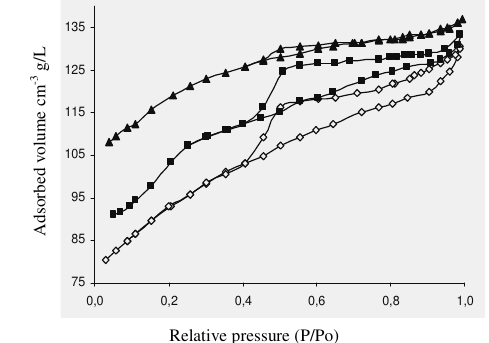
Figure 4b. N physical adsorption and 2 desorption isotherms: ( ▲ ) Ni-Cu-ZSM-5, ( ■ ) Ni-ZSM-5, ( ◊ ) Cu-ZSM-5.